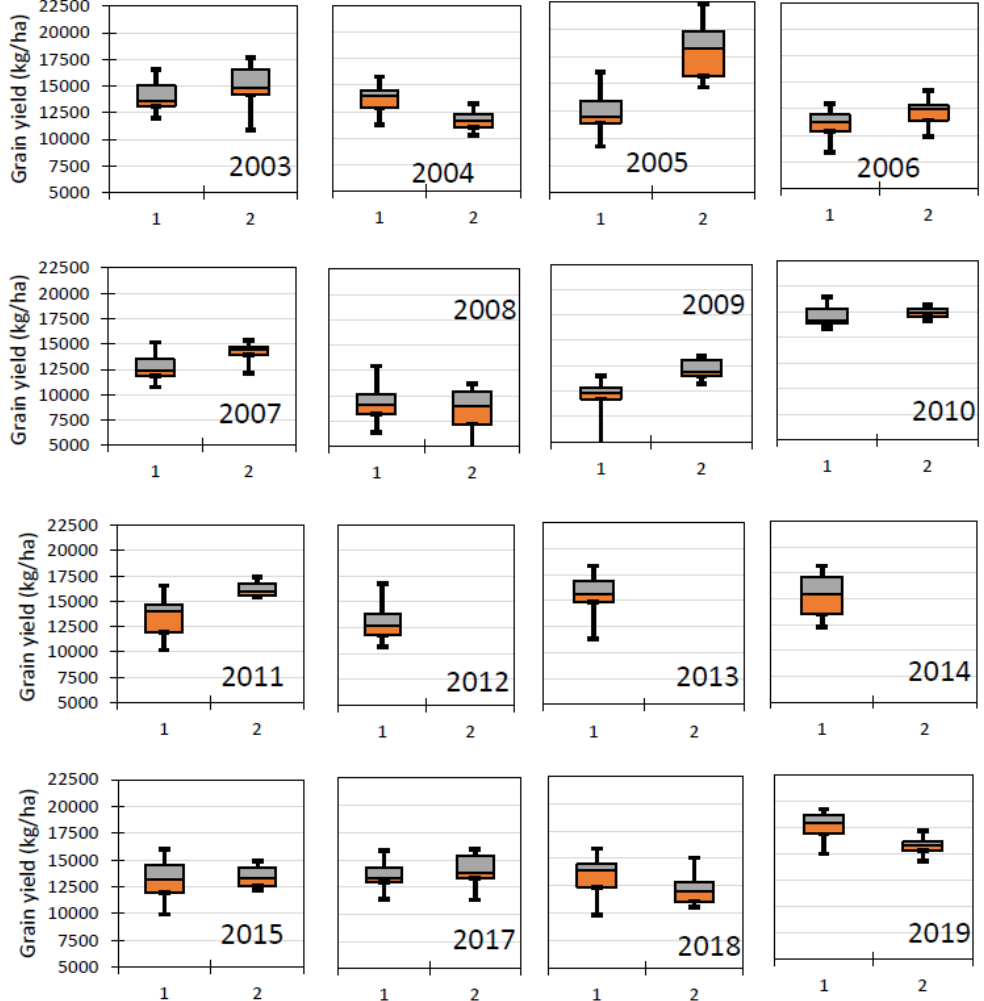
Figure 6. Boxplots of the early season (1) and full season (2) hybrid maize grain yield for the 2003–2019 period.